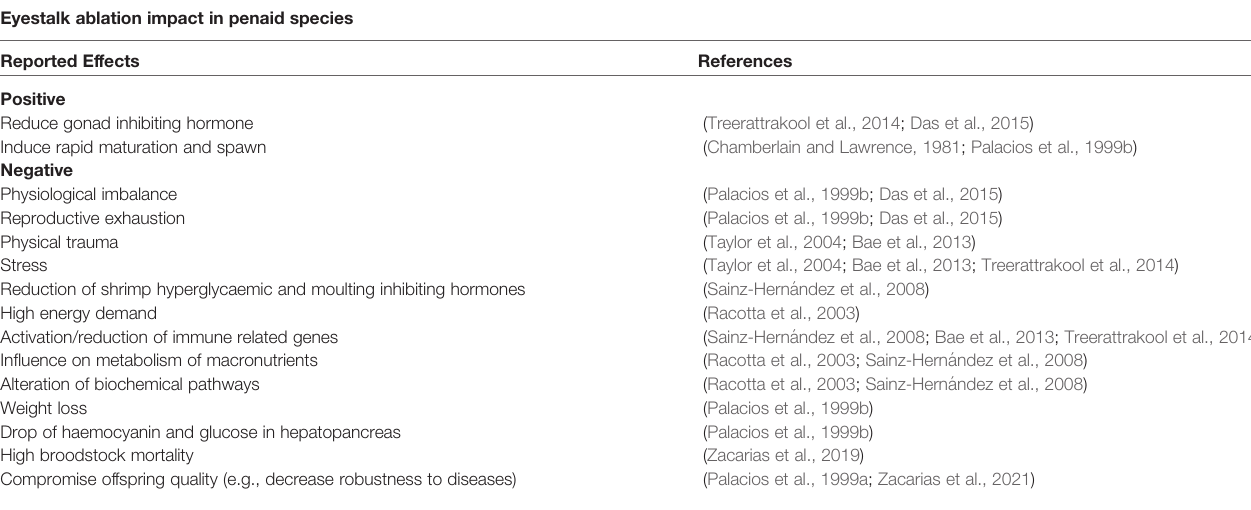
TABLE 1 | Summary of eyestalk ablation effect in Penaeids (includes data from P. vannamei , P. monodon and P. stylirostris ). Eyestalk ablation impact in penaid